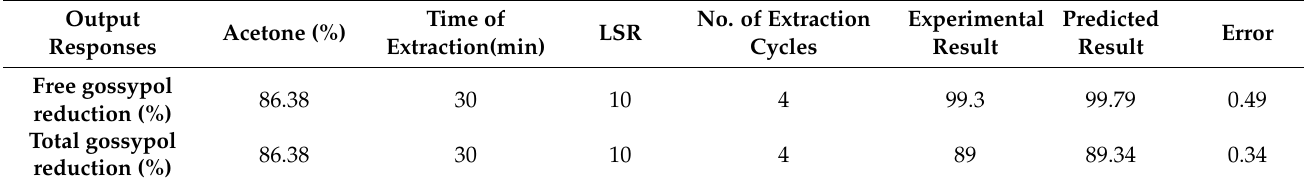
Table 7. Validation test results of optimized